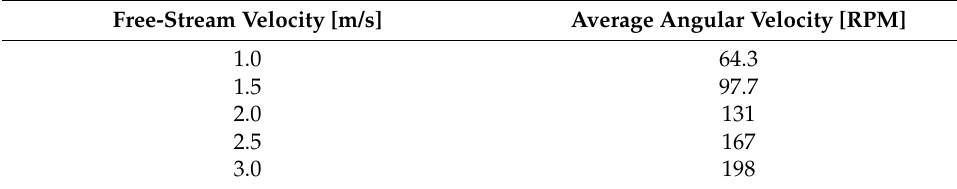
Table 3. Average angular velocity of the rotor for each simulated free-stream velocity.